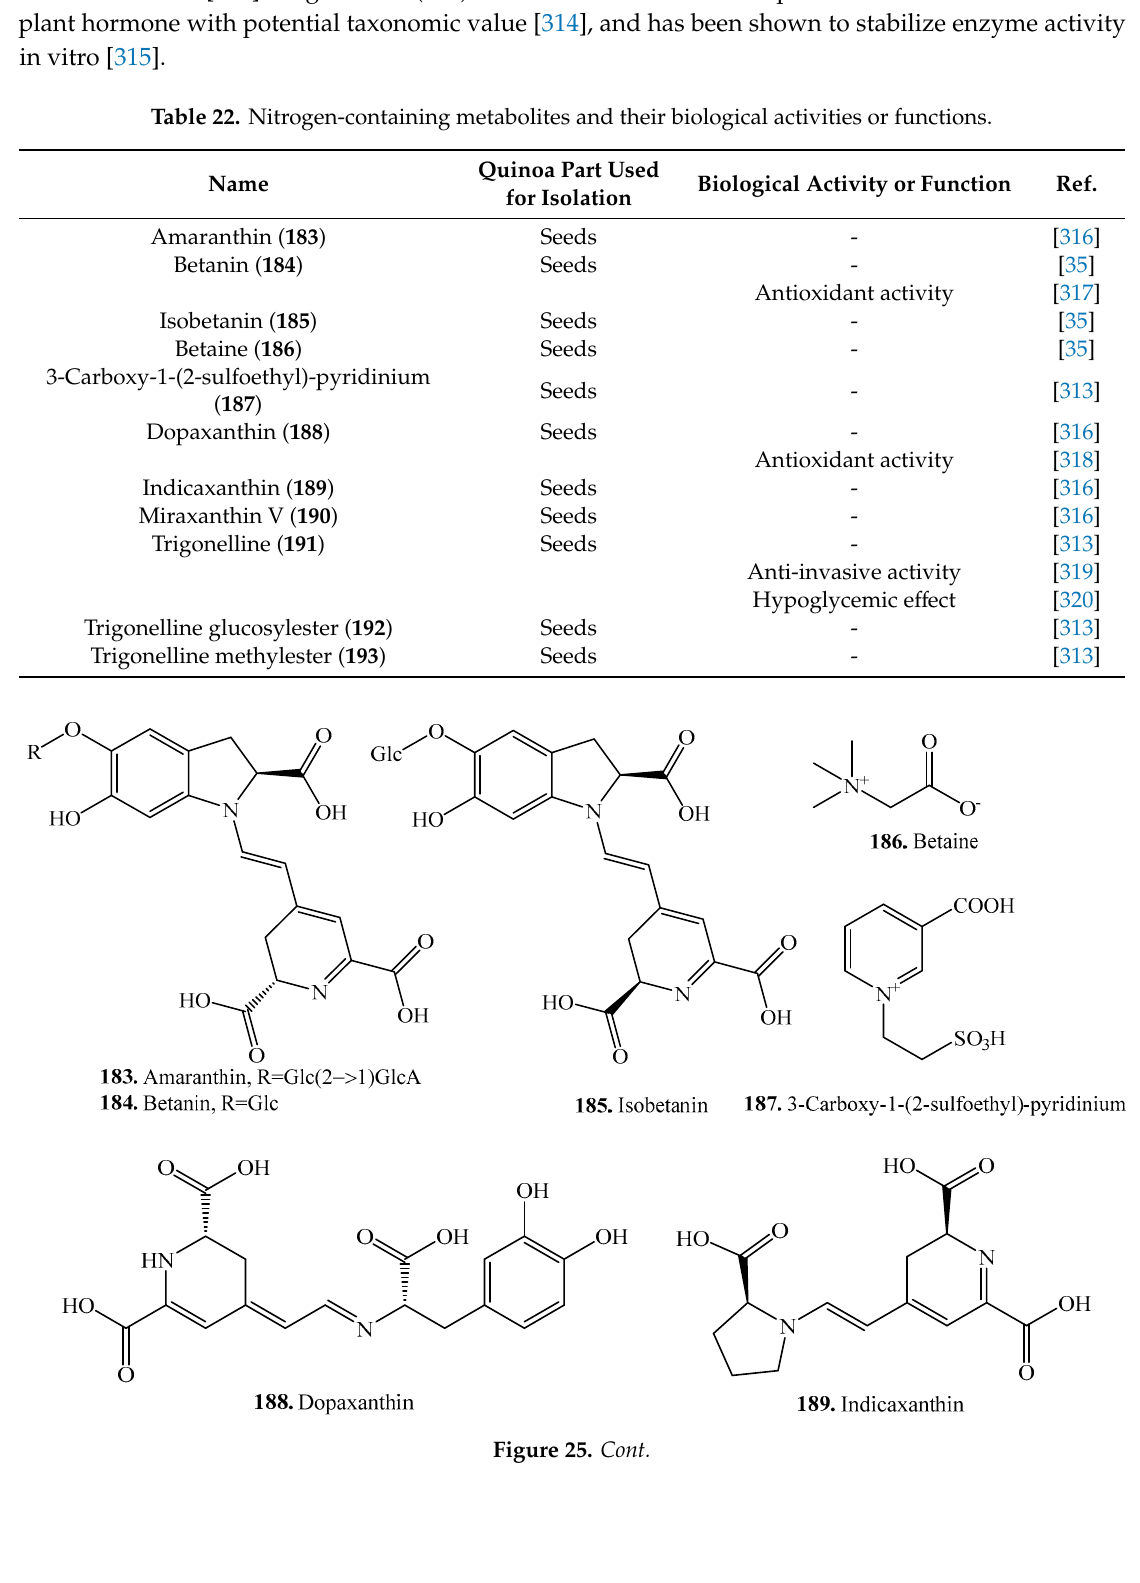
Figure 25. Structures of the nitrogen-containing metabolites isolated from quinoa. 7. Conclusions and Future Perspectives This review focuses on the structures, isolation parts, biological activities or functions of quinoa secondary metabolites during the past 40 years. Flavonoids and phenolic acids were mostly derived from quinoa seeds. Steroids were mostly separated from quinoa bran. Triterpenoids were also mainly located in the bran. Their biological activities or functions have been reported but not comprehensive, and are needed to be systematically evaluated in the future. The bitter taste associated with saponins (triterpenoids) greatly limits the use of quinoa as food [18]. Approximately 34% of quinoa saponins are present in the bran, indicating that dehulling could remove almost one half of the saponins. The seeds should be milled to remove the bran (seed coats) to make them edible [239]. Another method to remove saponins from the seeds is washing due to the high water solubility of saponins although this method can lead to the loss of some nutrients such as vitamins and minerals [18]. With the increased demand for quinoa, the problem that comes with it is that the bran is discarded as an industrial production waste. In order to increase the added value of quinoa, the bran (seed coat) should be fully exploited and utilized [321]. Quinoa saponins have shown their great potential applications. They can be used in the pharmaceutical industry as the saponins can induce changes in intestinal permeability which can be useful for the absorption of specific medicines and in